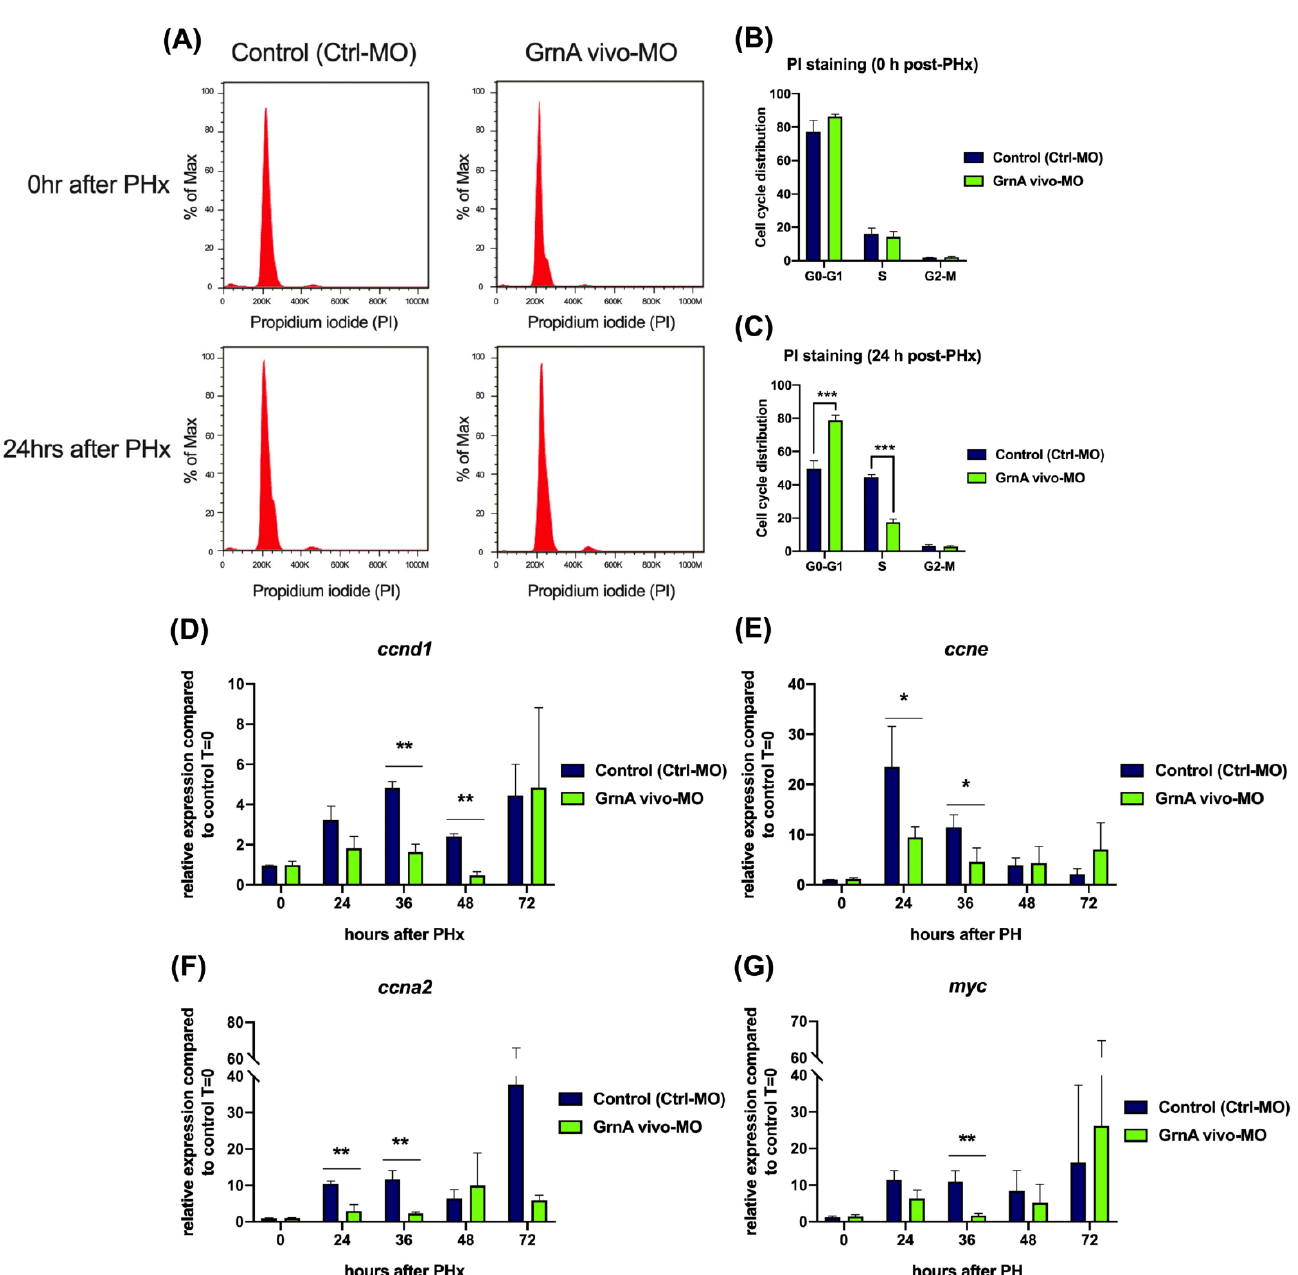
Figure 4. Cell cycle progression and cell proliferation were suppressed in GrnA morphants after PHx. ( A ) Cell cycle analysis of hepatectomized control and GrnA morphant zebrafish for 0 h (upper) and 24 h (lower) after PHx. PI staining was performed, and samples were analyzed using flow cytometry. The proportion of cells at each stage at 0 h ( B ) and 24 h ( C ) after PHx was analyzed by Flow-Jo software and is presented as mean ± SD. The cell cycle regulatory genes included ( D ) ccnd1 , ( E ) ccne , and ( F ) ccna2 , and ( G ) myc , the cell proliferation related gene, was probed by quantitative PCR. Data are shown as relative expression of indicated genes normalized to control 0 h after PHx. EF1a served as the internal control. Significance was set at * p < 0.05, ** p < 0.01, *** p < 0.001, as determined by t -test; PHx, partial hepatectomy.